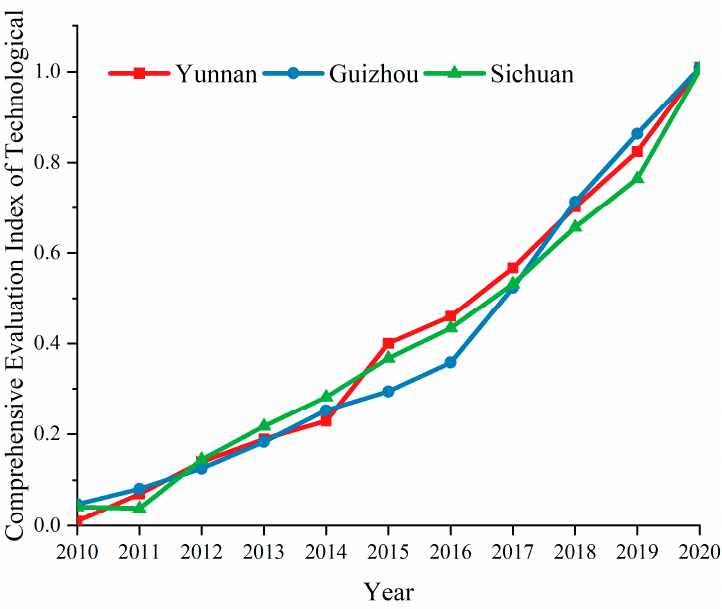
Figure 7. Temporal changes of the technology development level.